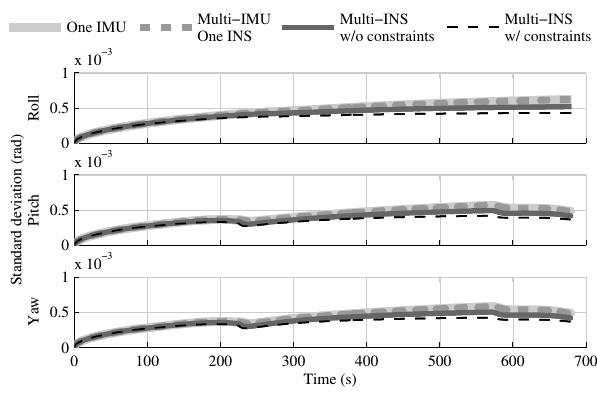
Figure 4. The attitude estimation error standard deviation obtained with the navigation solutions, when all sensor measurements are present.